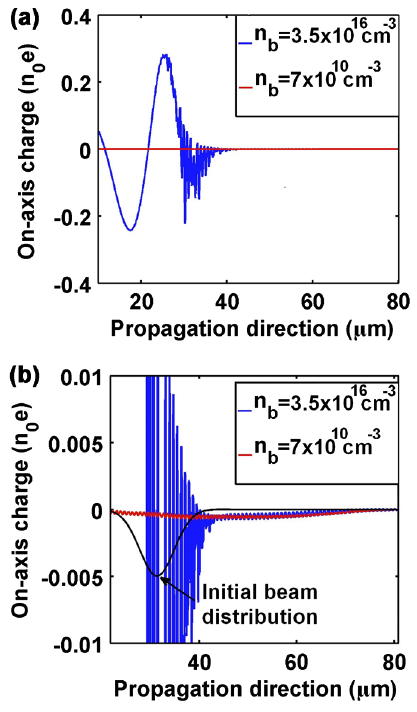
FIG. 6. On-axis charge density after 4.2 ps of acceleration with a 0 ¼ 0 : 1 . (b) Vertically magnified image of (a). The blue FIG. 5. Transverse position-longitudinal momentum phase line is the on-axis charge density for high beam density, ¼ 3 : 5 (cid:4) 10 16 cm (cid:1) 3 , and the red line is for low beam density, n space of the beam electrons after 9 mm acceleration for a 0 ¼ b ¼ 200 (a) low beam density, n ¼ 7 (cid:4) 10 10 cm (cid:1) 3 , ¼ 7 (cid:4) 10 10 cm (cid:1) 3 . The black line in (b) indicates the initial 0 : 1 and (cid:1) n 0 b b ¼ 3 : 5 (cid:4) 10 16 cm (cid:1) 3 . and (b) high beam density, n beam electron b